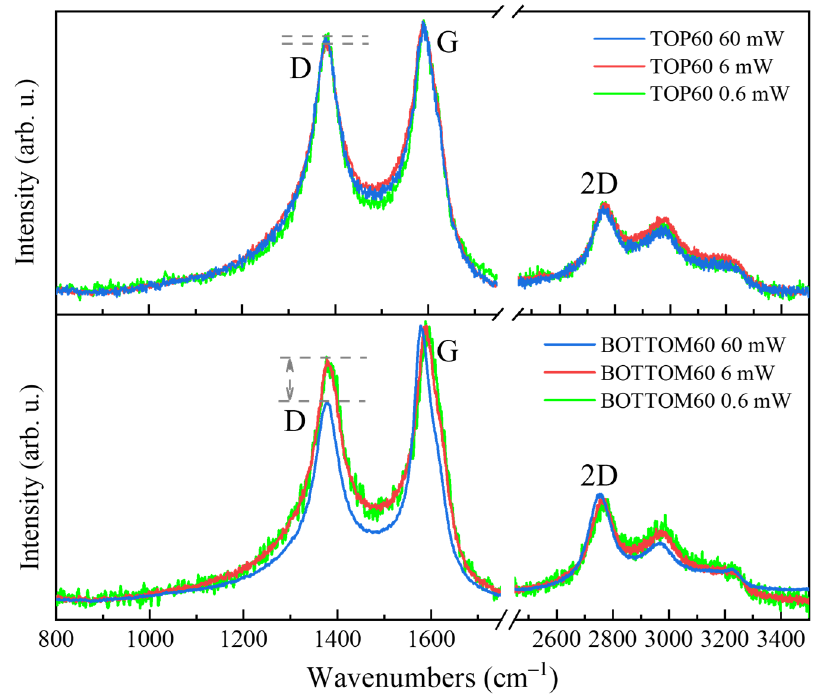
Figure 13. Raman spectra of the GNPs samples of TOP60 and BOTTOM60 excited by blue ( λ exc = 405 nm) laser at different power values at the same point.